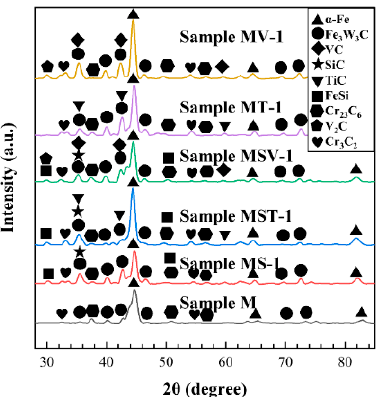
Figure 4. The SEM-SE micrographs of the S390 MMCs with different volume fractions of carbide.